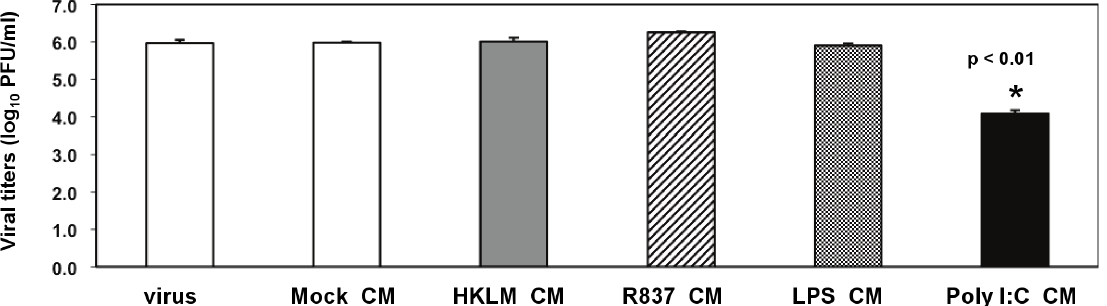
Figure 5. Involvement of soluble factors in the antiviral effect mediated by TLR3 in poly I:C-stimulated, MHV-infected macrophages. J774A.1 macrophages were pretreated for 3 h with the conditioned medium (CM) from macrophages prestimulated with TLR ligands for 6 h from Figure 2. CM was diluted 1:1 with the basal medium to replenish nutrients. Then cells were infected with RA59-GFP (1 MOI) for 1 h adsorption and incubated in the basal medium for up to 18 h p.i. Cells pretreated with the CM from mock cells or with fresh basal medium served as negative controls for the TLR-triggered effect. RA59-GFP titers were assessed in cell-free supernatants using a plaque assay on L2 fibroblasts. Error bars represent the standard error of the mean of two replicates ( p value relative to cells pretreated with CM from mock, p < 0.01, Student’s t